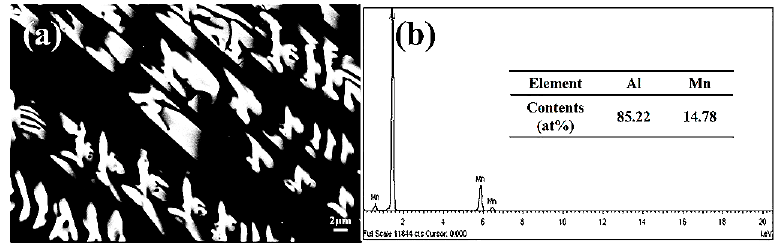
Figure 5. ( a ) Microstructure and ( b ) EDS of block crystals in cross-section of the cylindrical sample.